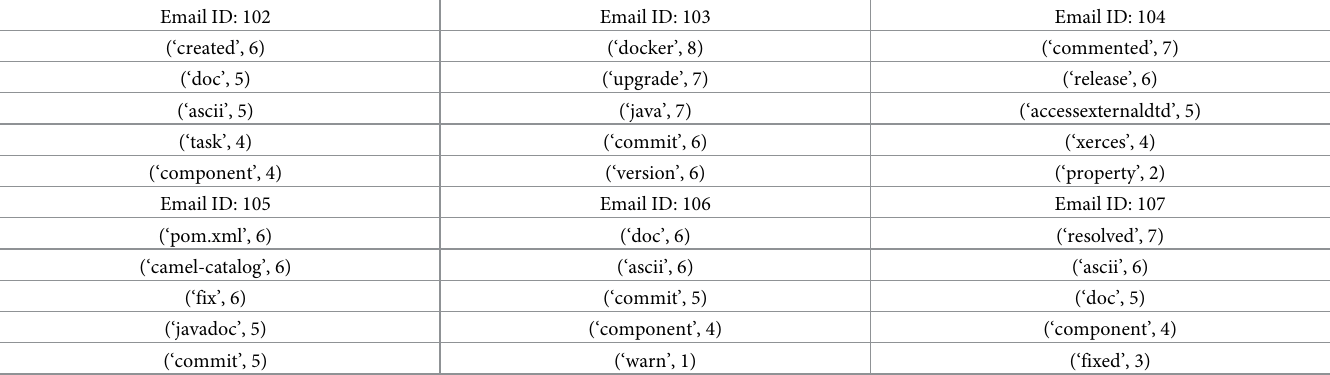
Table 2. Consensus of keyword labels for emails 102-107 following the Delphi process meetings.